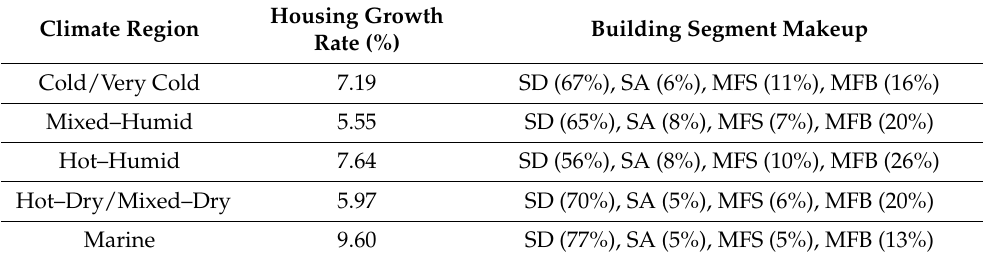
Table 3. Housing growth rate for baseline